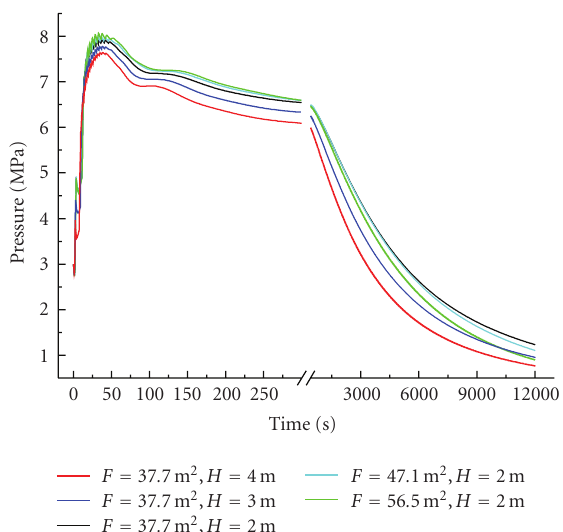
Figure 11: Pressure of the secondary loop with di ff erent height di ff erences and heat transfer areas.